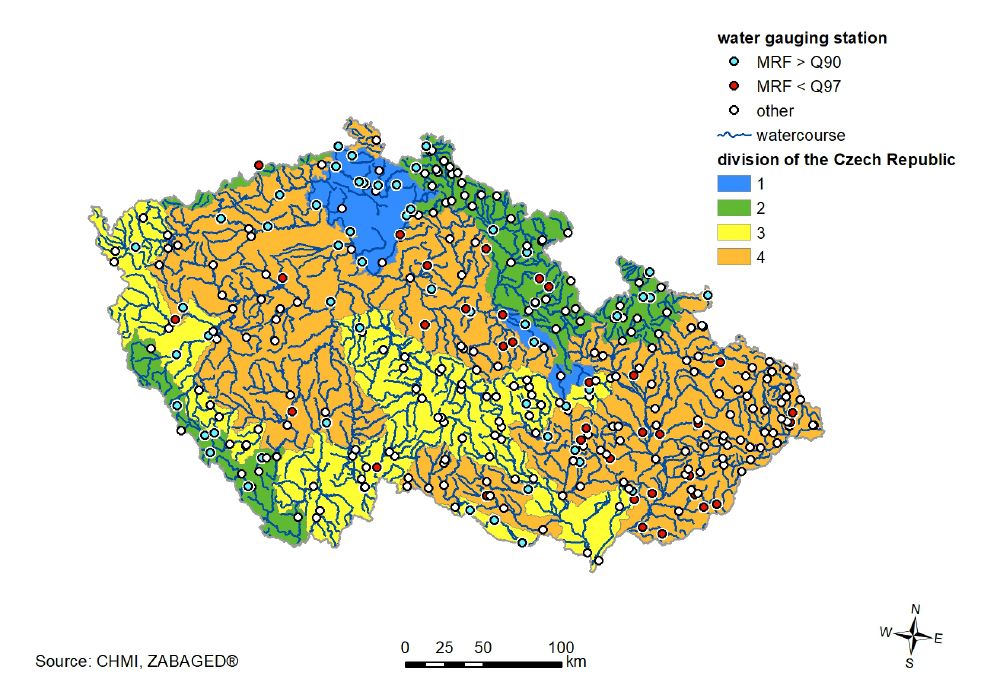
Figure 8. Evaluation of MRF calculation according to Equation (5) and Table 3. Red dots show profiles where the water flow of at least Q 97 is not achieved - for those, the MRF value is set to Q 97 , and green dost are profiles where the water flow is higher than Q 90 —for those, the MRF value is set to Q 90 .